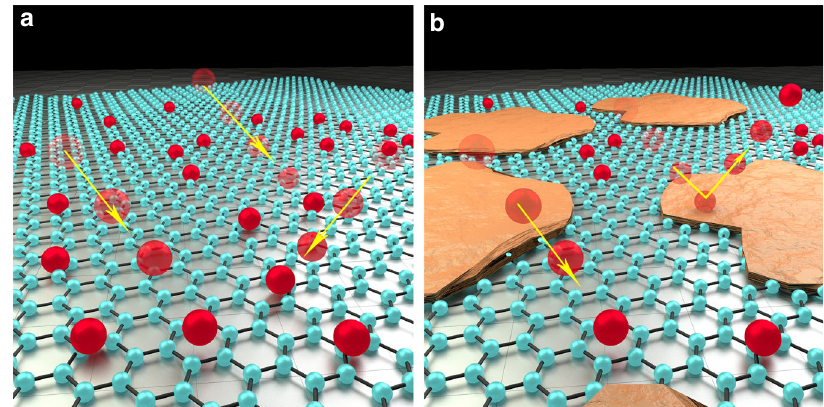
Fig. 1 Schematic representation of the available surface area of graphene for molecular interaction. a Pure surface vs b contaminated surface. The red spheres represent molecules that can interact with the surface, while the orange rafts represent the